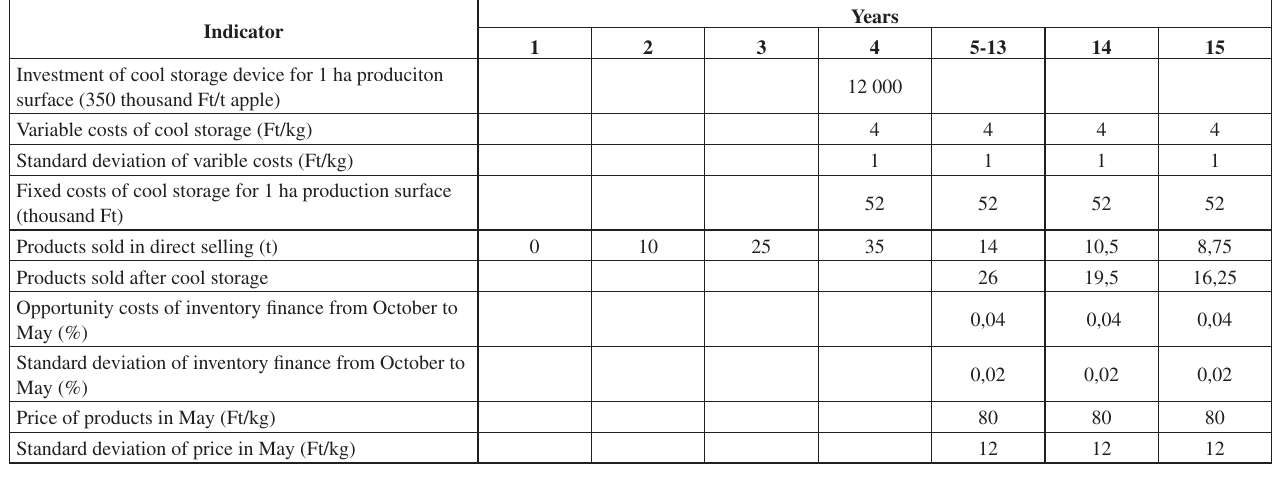
Table 3. Base data of the apple-production and cold storage model